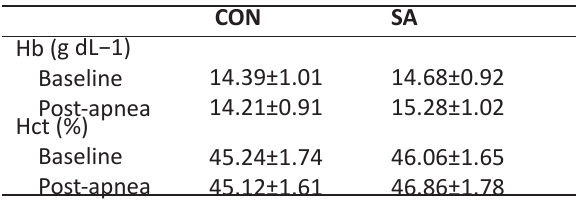
Table 3. Effects of repeated static apneas on Hb and